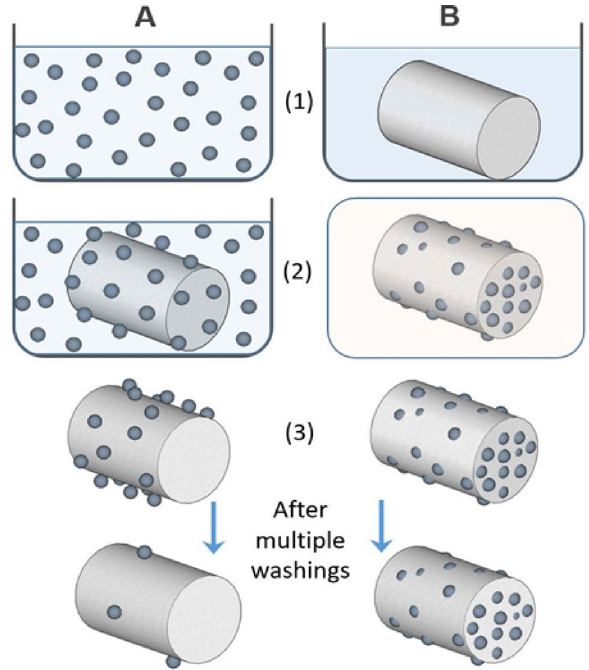
Figure 1. Comparison of ( A ) conventional dip-coating process with ( B ) thermal Crescoating technology. ( A ) Wet synthesis of nanoparticles by chemical reduction (1), dip-coating of the textile in the nanoparticle (2), followed by washing and drying (3). ( B ) Impregnation of the textile in precursor solution (1), Thermal reduction by heating the textile at 100 °C (2), followed by washing and drying